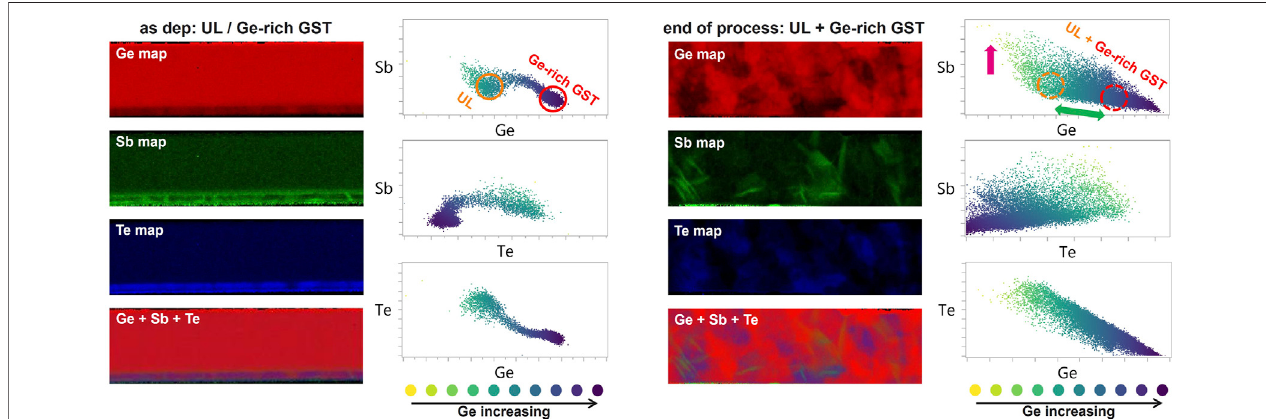
FIGURE 1 | Chemical analysis of “ as-deposited ” and “ end-of-process ” PCM stack: signal maps of the three main elements (Ge, Sb, and Te) are reported together with elemental scatter plots of Sb vs. Ge, Sb vs. Te, and Te vs. Ge, where the color code from yellow to violet is proportional to Ge content. Superposition of main elements ’ signal maps is also reported. Magenta and green arrows in the top right plot indicate the main directional spread of the compositional distribution.